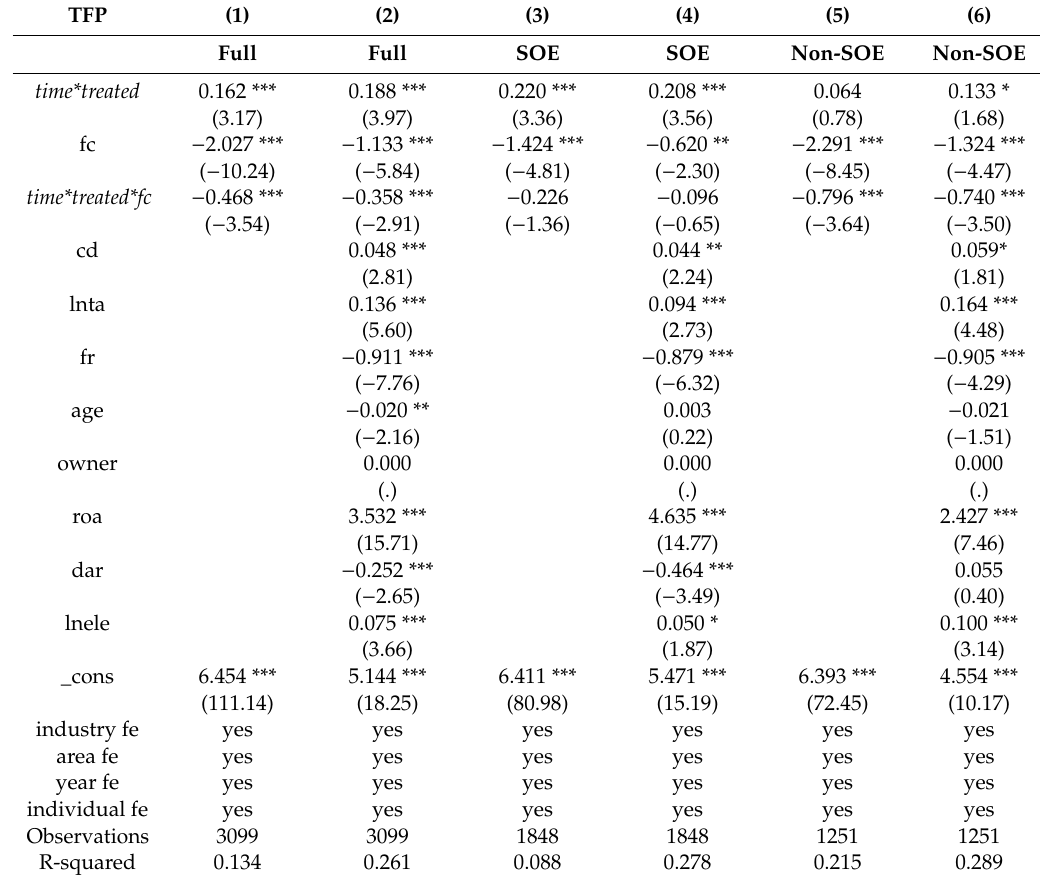
Table 7. Results of moderating e ff ect of financing